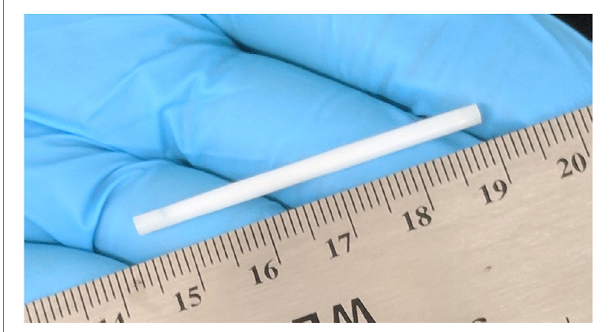
FIGURE 1 | A digital camera image of the biodegradable implant. All implants were 2.5 mm in outer diameter (OD) and 46 mm in total implant length with a 40 mm reservoir and two 3 mm PCL end